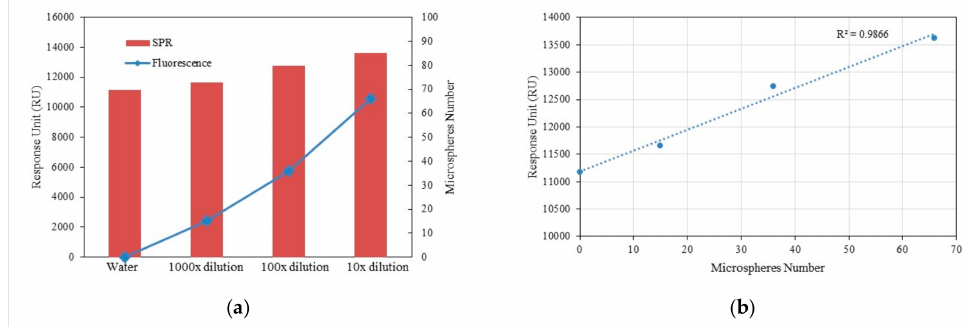
Figure 6. ( a ) The relationship between fluorescent signal (water, 1000 × , 100 × , and 10 × diluted microspheres) and SPR detection signal (serial 1); ( b ) linear correlation coe ffi cient between the whole fluorescence signal and SPR detection